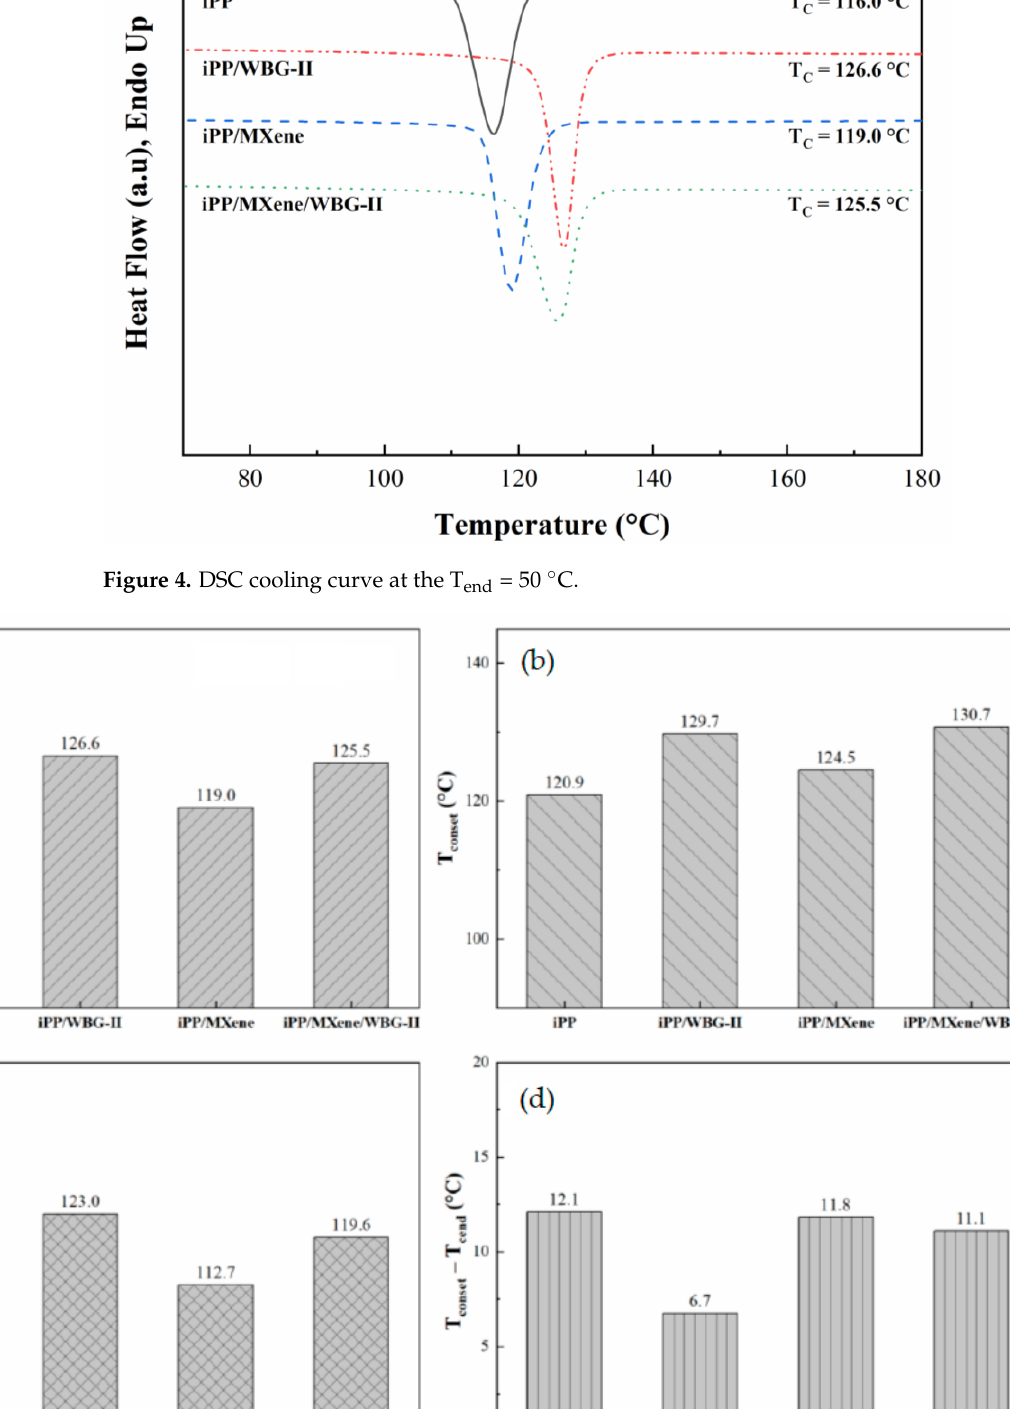
Figure 5. Plots of ( a ) T c , ( b ) T conset , ( c ) T cend , ( d ) T conset − T cend of four samples from the cooling curve at T end = 50 °C.